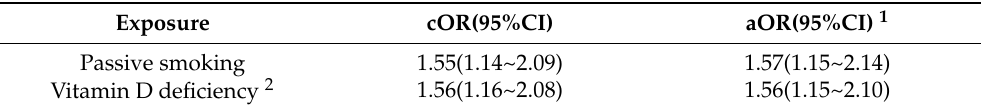
Table 2. Analysis of association of passive smoking and vitamin D deficiency with risk of spontaneous